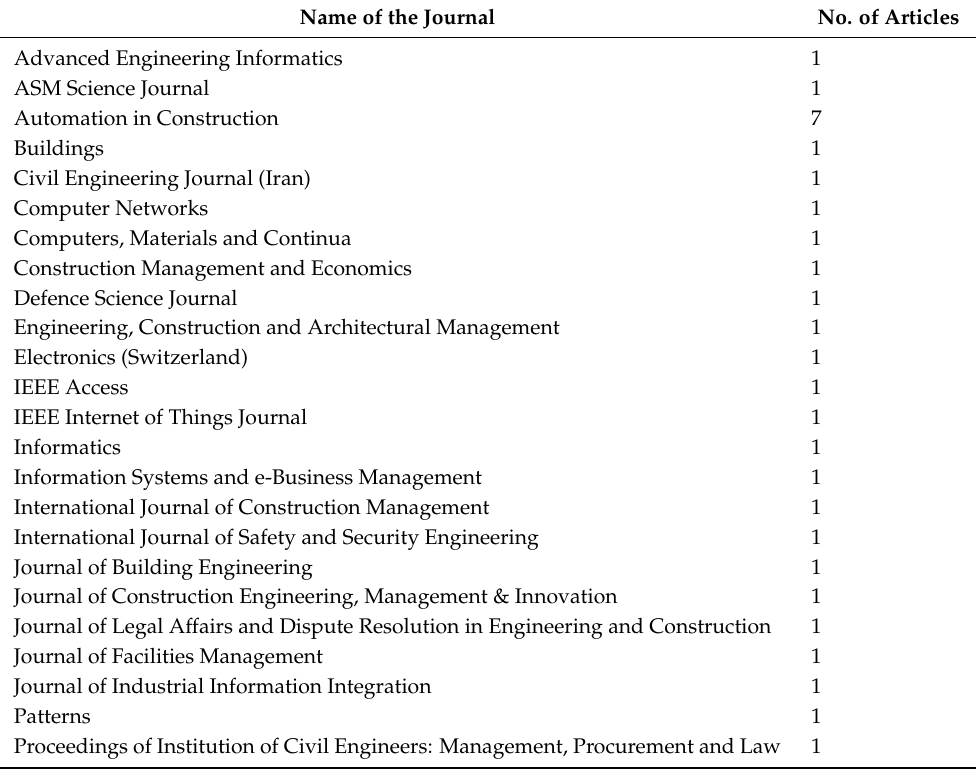
Table 3. List of Journals that contributed to the SCs in the construction industry.